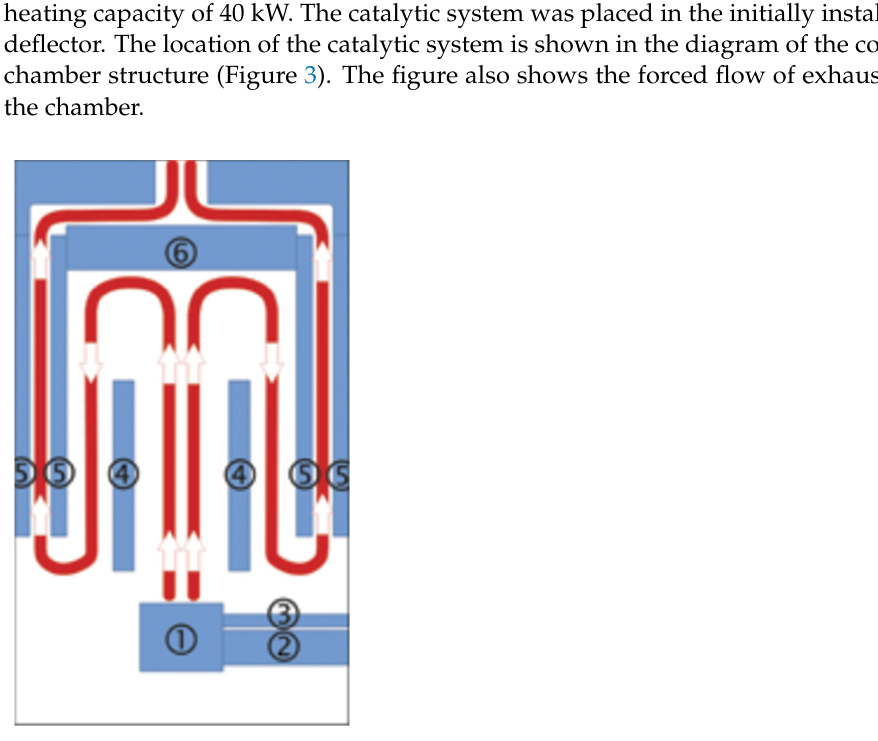
Table 4. Technical specification of PerkinElmer CHNS/0 2400 apparatus.